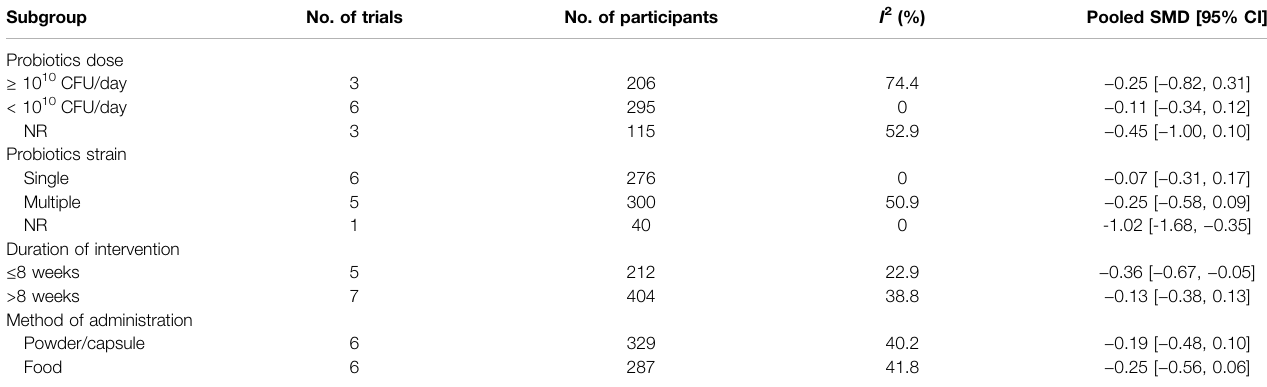
TABLE 4 | Subgroup analysis for the effects of probiotics on CRP.